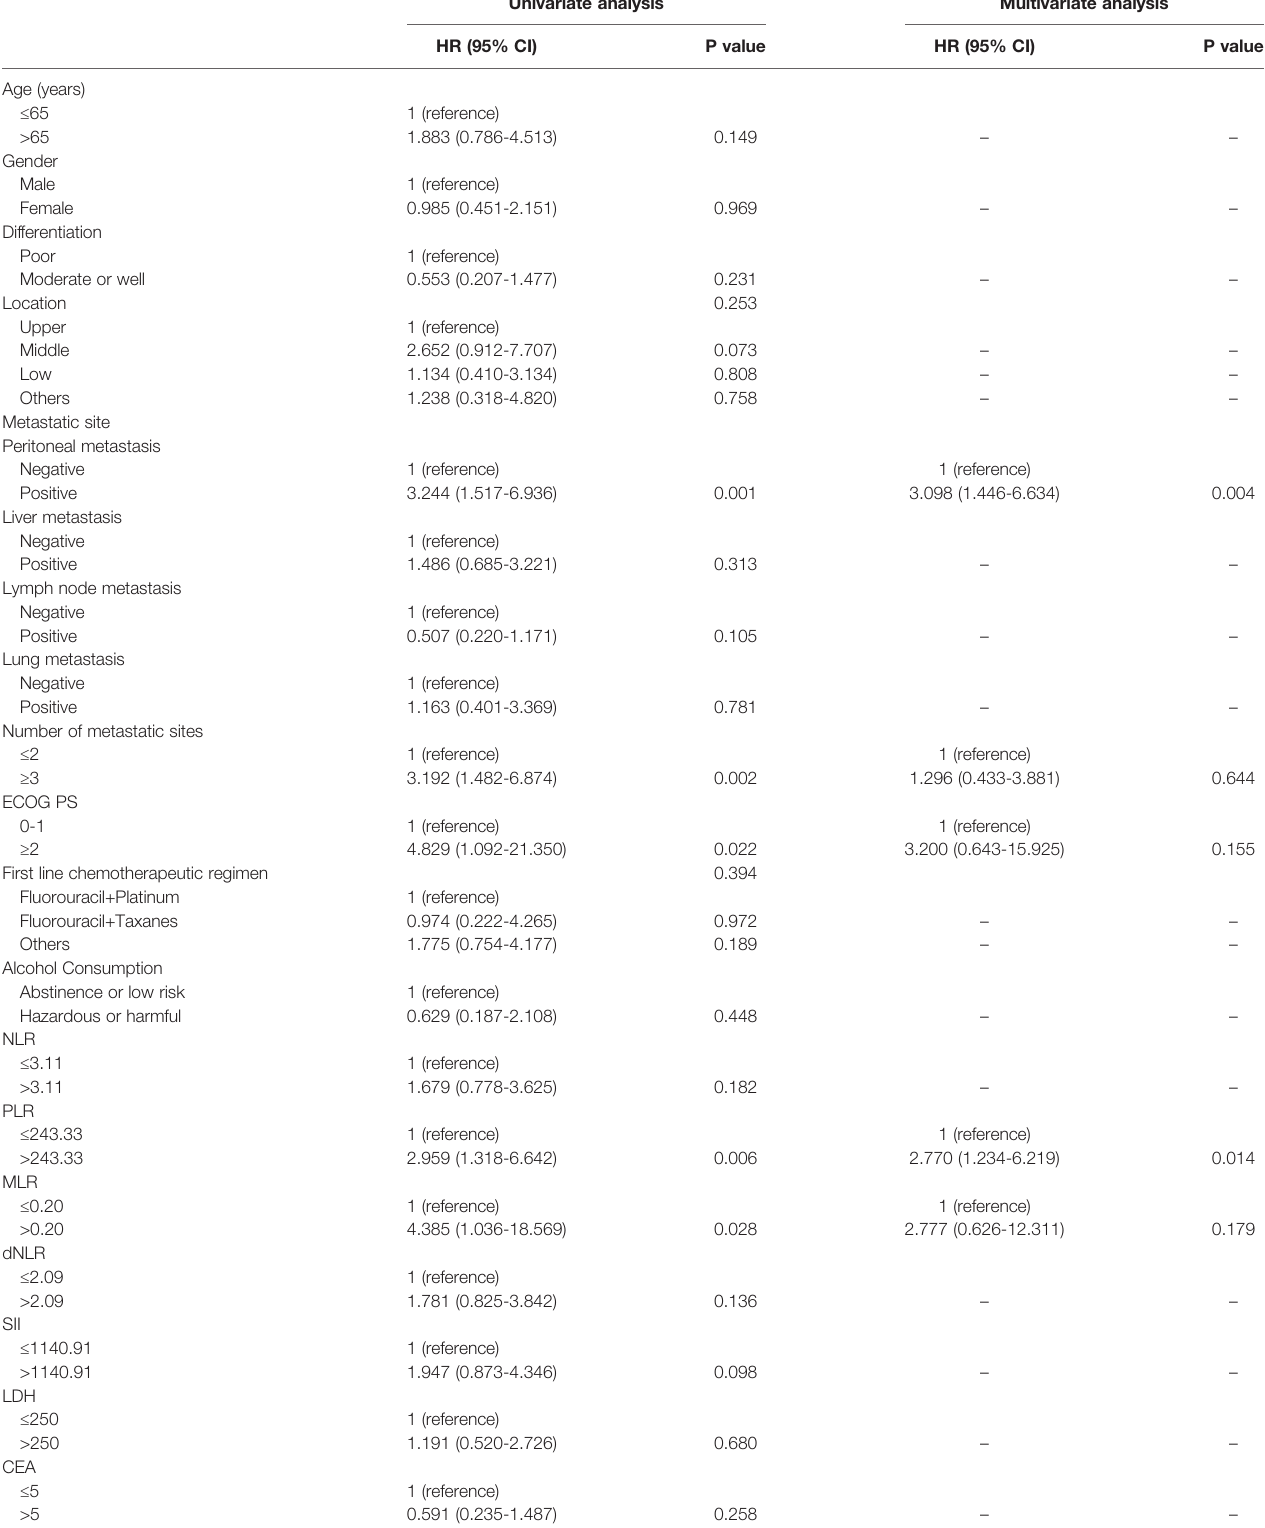
TABLE 3 | Univariate and multivariate analysis of factors according to OS in AGC patients treated with anti-PD-1 drugs in the fi rst-line